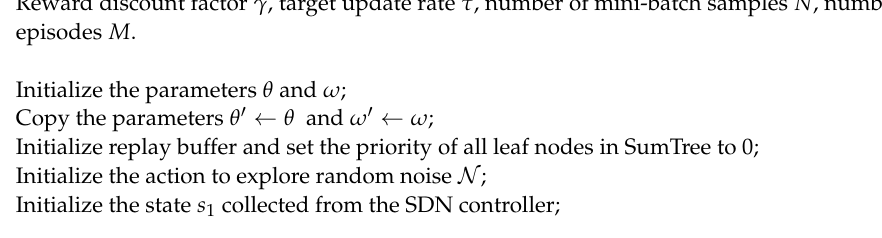
Algorithm 2 : AQMDRL training